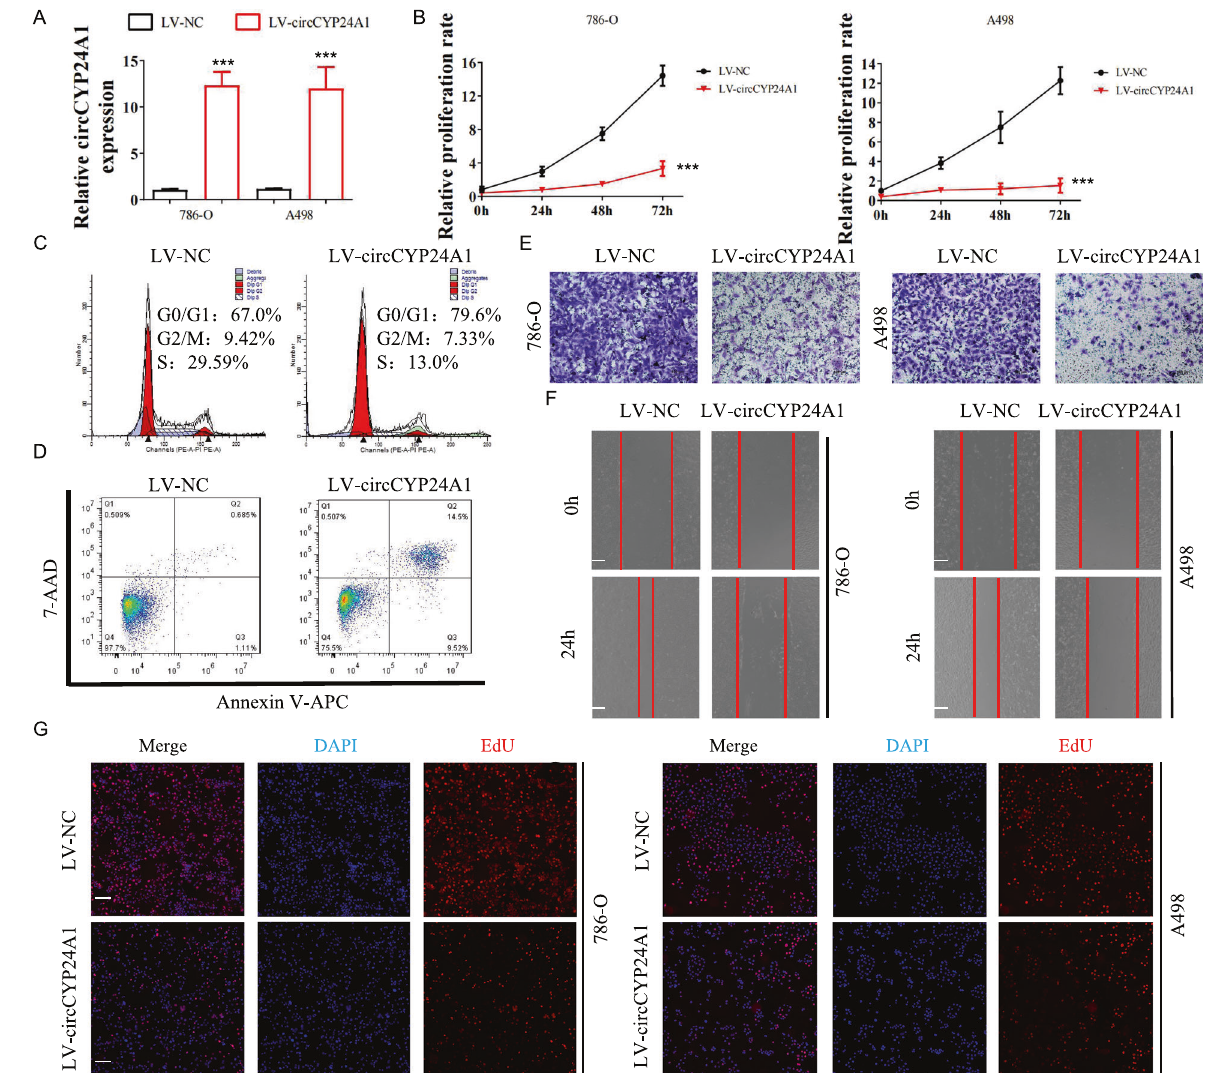
Fig. 2 Overexpression of circCYP24A1 inhibits the tumorigenesis of RCC cells in vitro. A Relative expression of circCYP24A1 was evaluated using qRT-PCR in 786-O and A498 cell lines transfected with LV-NC or LV-circCYP24A1. B Relative proliferation rates were evaluated in 786-O and A498 cell lines transfected with LV-NC or LV-circCYP24A1. The cell cycle distribution ( C ) and apoptosis rate ( D ) were evaluated in 786-O cell lines transfected with LV-NC or LV-circCYP24A1 using fl ow cytometry. Transwell assays ( E ) and wound-healing assays ( F ) were performed in 786-O and A498 cell lines transfected with LV-NC or LV-circCYP24A1. The bar corresponds to 300 μ m in the wound-healing assay. G An EdU assay was performed to measure the proliferation of 786-O and A498 cell lines transfected with LV-NC or LV-circCYP24A1. The bar corresponds to 100 μ m. Data are presented as means ± SD. *** p <